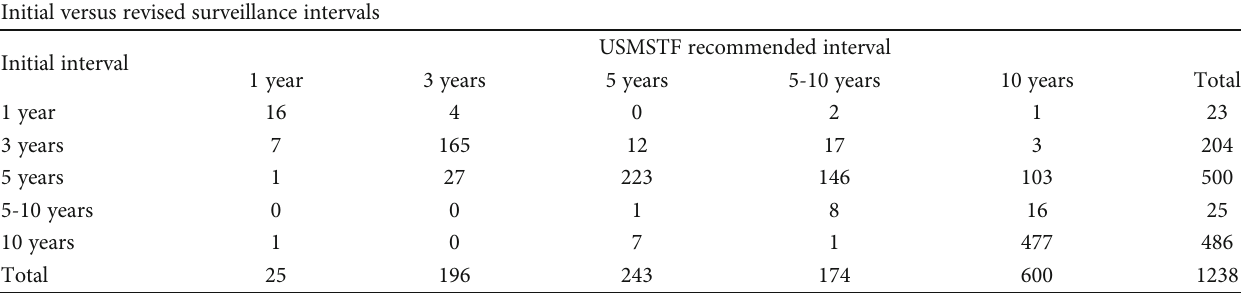
Table 5: Revised surveillance intervals based on USMSTF guidelines ( n = 1238